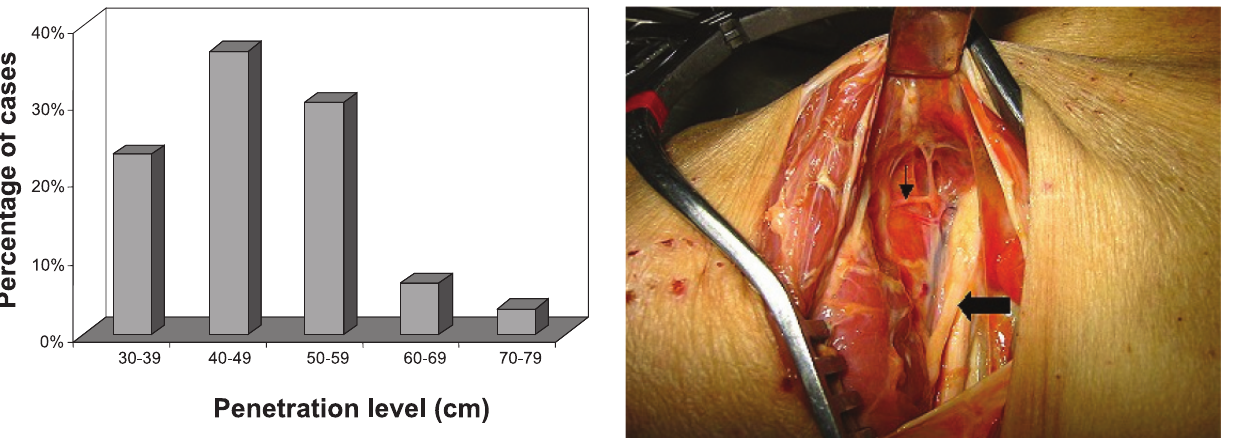
Figure 4 - Left shoulder: the musculocutaneous nerve (wide arrow) laterally to the median nerve, and origin of the acromial artery (narrow arrow), a branch of the deltoid